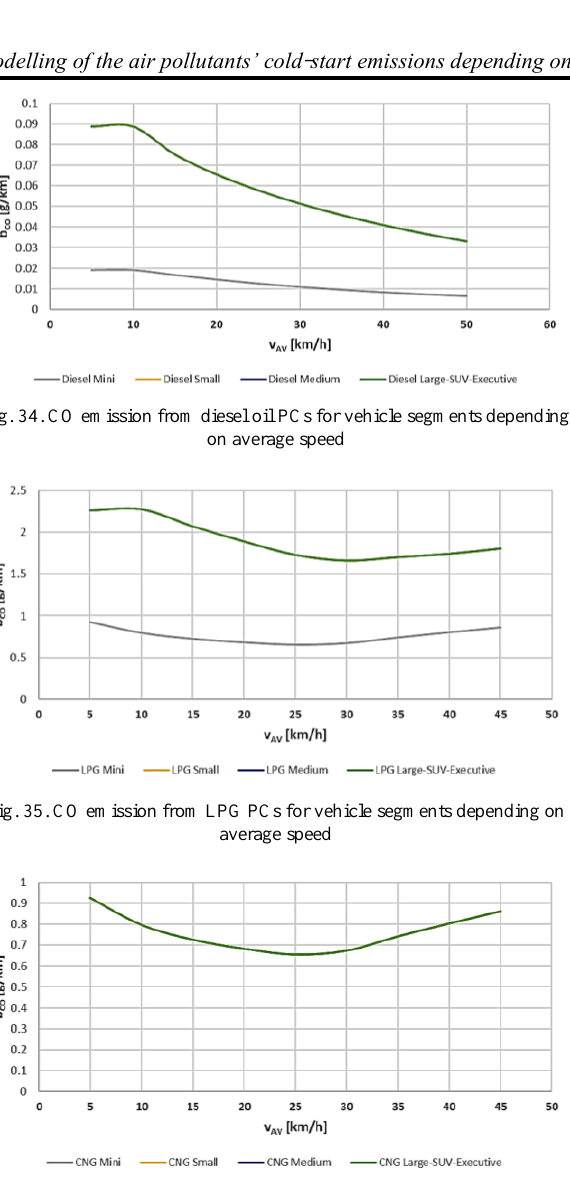
Fig. 36. CO emission from CNG PCs for vehicle segments depending on average speed